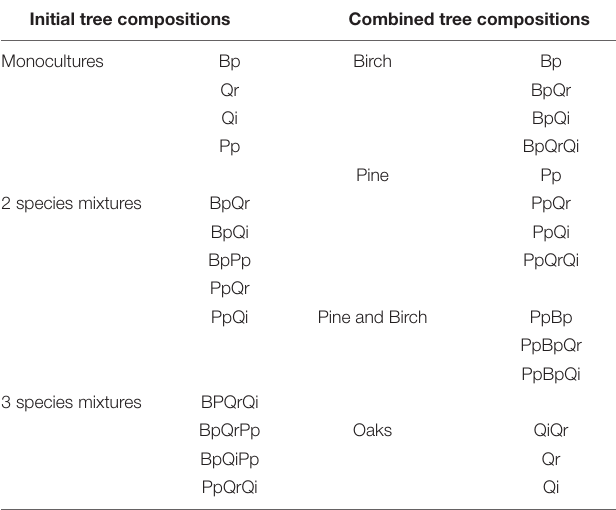
TABLE 1 | Table representing the combination of the different tree compositions chosen for the analyses. Initial tree compositions Combined tree